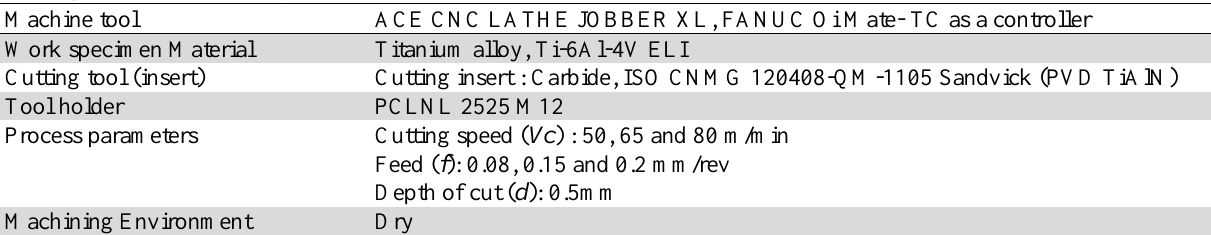
Cutting condition for experimental